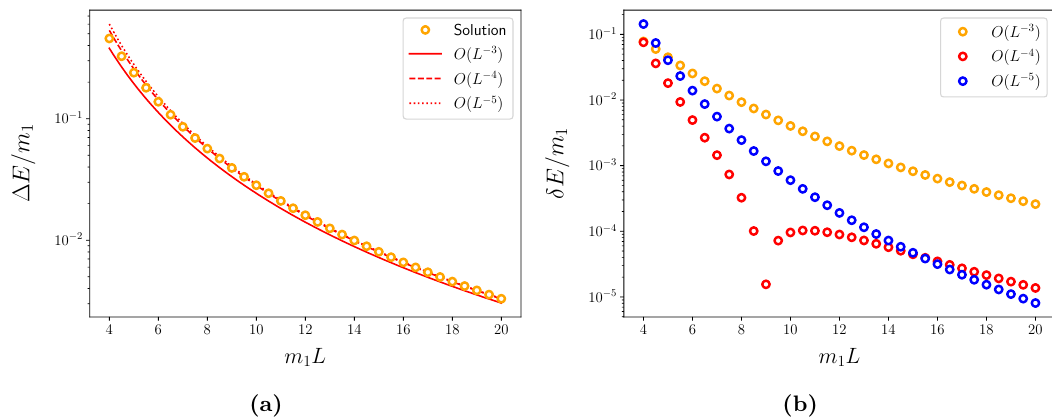
Figure 3. Numerical comparison between the results from the quantization condition and the threshold expansion. (a) Energy shift as a function of the box size. Orange dots show the numerical solutions to the quantization condition, while the various red lines are the theoretical predictions of eq. (4.1), truncated to different orders in the 1 /L expansion. (b) Box-size dependence of the quantity in eq. (4.5), which is the absolute value of the difference between the threshold expansion at various orders and the numerical solution as a function of m 1 L